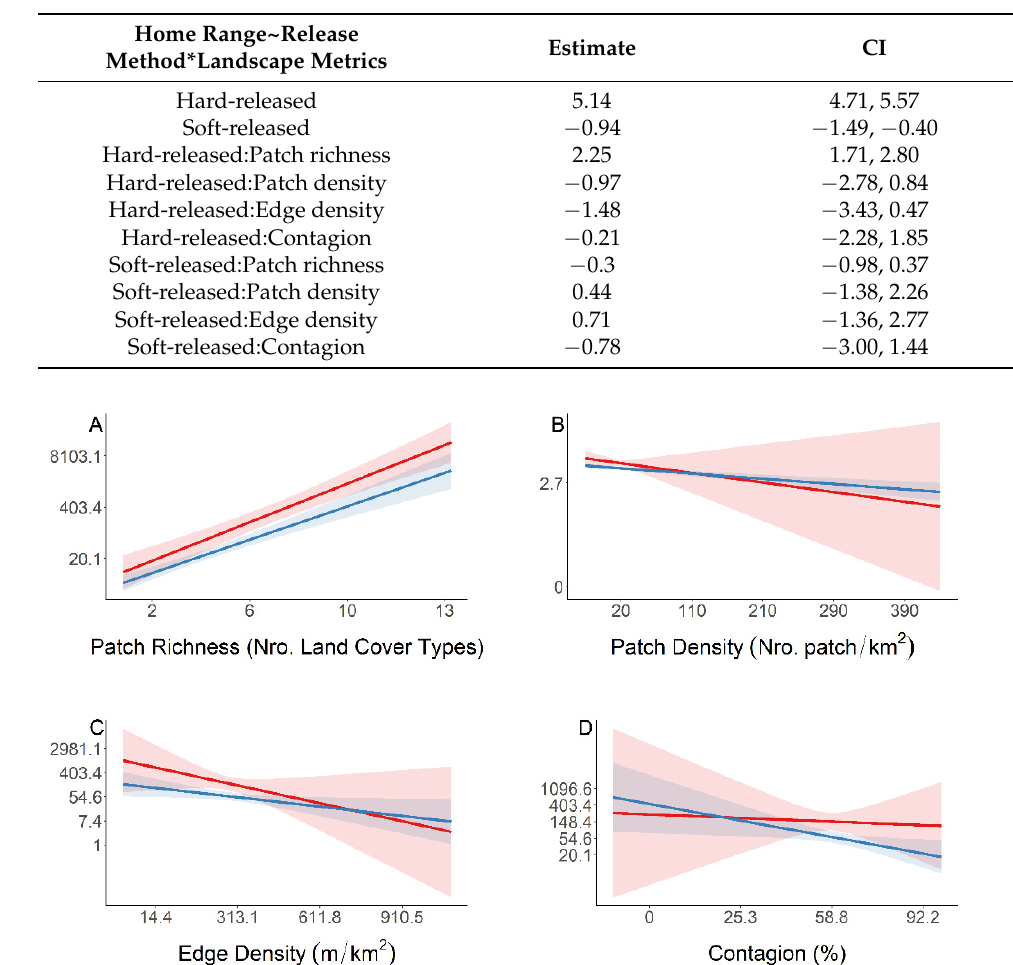
Table 2. Parameter estimates and 95% confidence intervals (CI) from the top-ranked model explaining the relationship of landscape metrics with the space use of captive-reared and wild-rehabilitated Harpy Eagles ( Harpia harpyja ) released in Central American forests between 2002 and 2009.